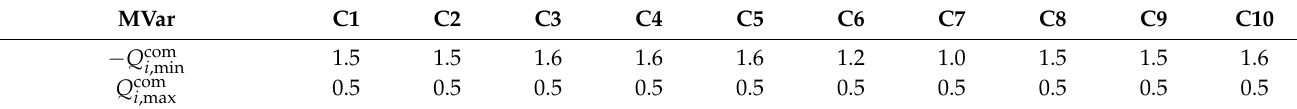
Table A4. Parameters of reactive power compensation device.